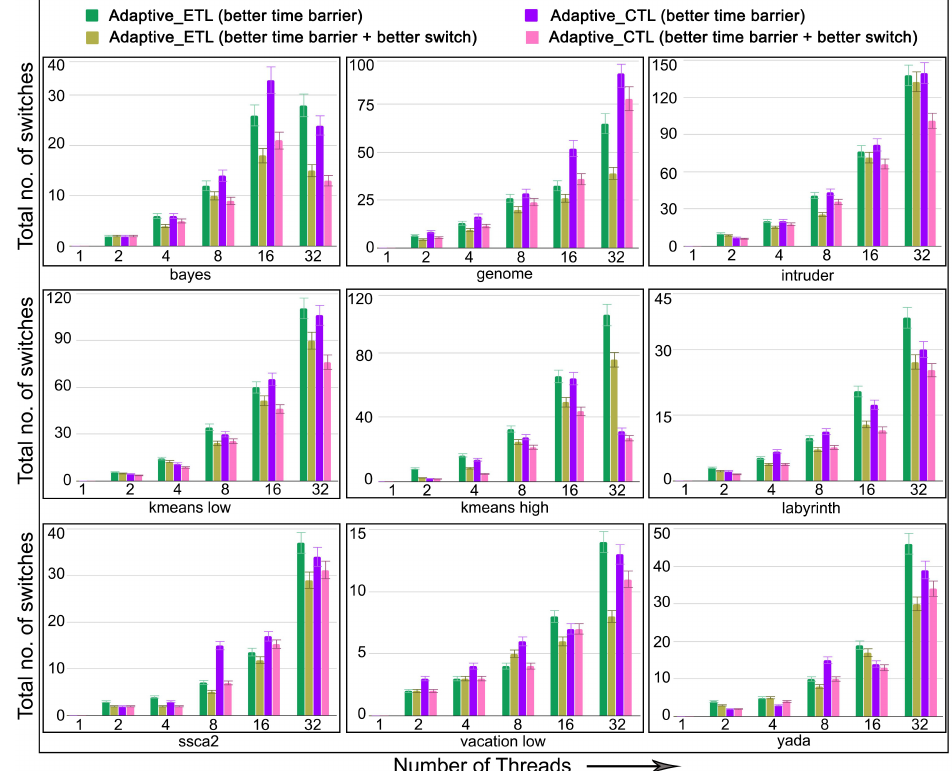
Figure 27. Decrease in total number of switches between versioning methods using better switch mechanism in non-persistent